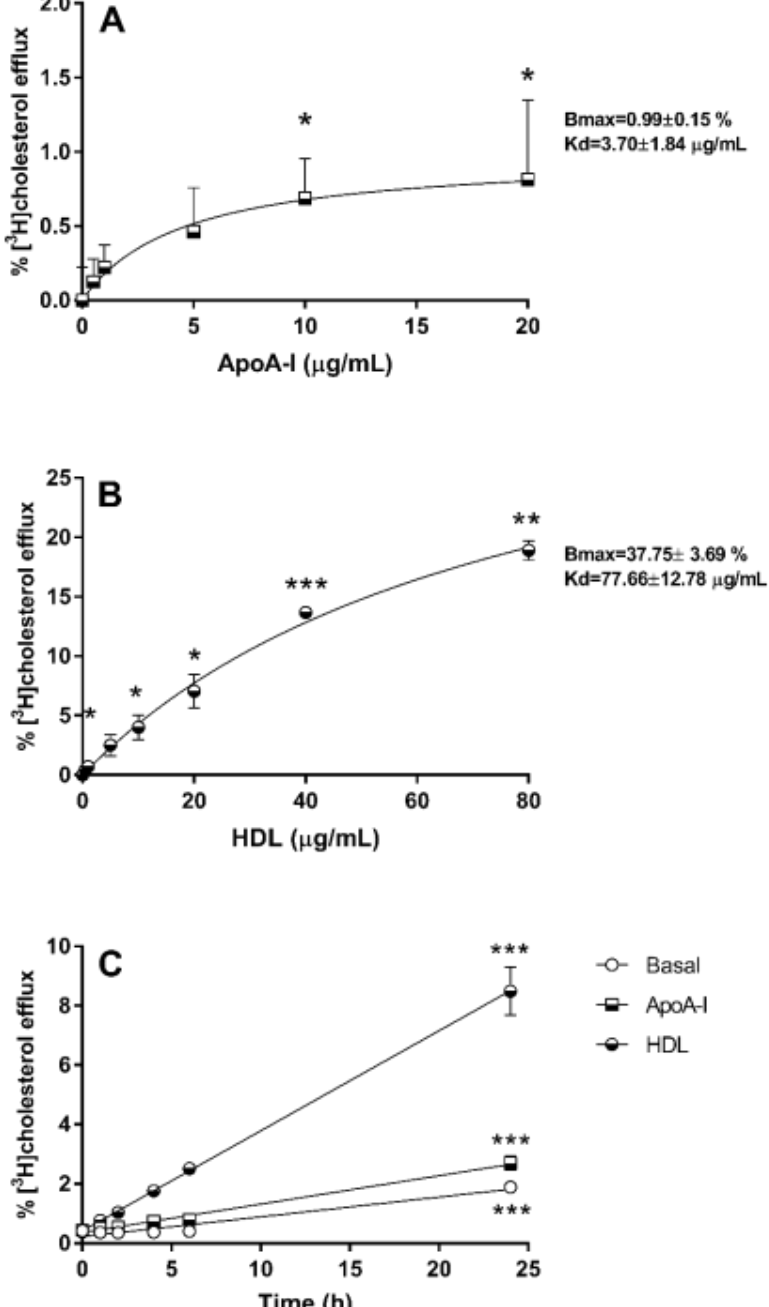
Figure 1. The dose dependencies of [ 3 H]cholesterol efflux to apoA-I (24 h) and HDL (24 h) are shown in ( A , B ), respectively. The data were analysed using repeated measures ANOVA with post hoc test (Dunnett’s) compared to the 0 µ g mL − 1 measurement; * p < 0.05, ** p < 0.01 and *** p < 0.001. Values are the mean ± SD of three independent experiments (each performed in triplicate). The time dependency of [ 3 H]cholesterol efflux under basal conditions, and to apoA-I (20 µ g mL − 1 ) and HDL (20 µ g mL − 1 ) is shown in ( C ). The data was analysed using two-way ANOVA with post hoc test (Dunnett’s) compared to the 0h timepoint; * p < 0.05, *** p < 0.001. Values are the mean ± SD of between three and four independent experiments (each performed in triplicate). Standard deviations, instead of SEM, have been shown, as the SEM for ( B , C ) are too small to be viewed.